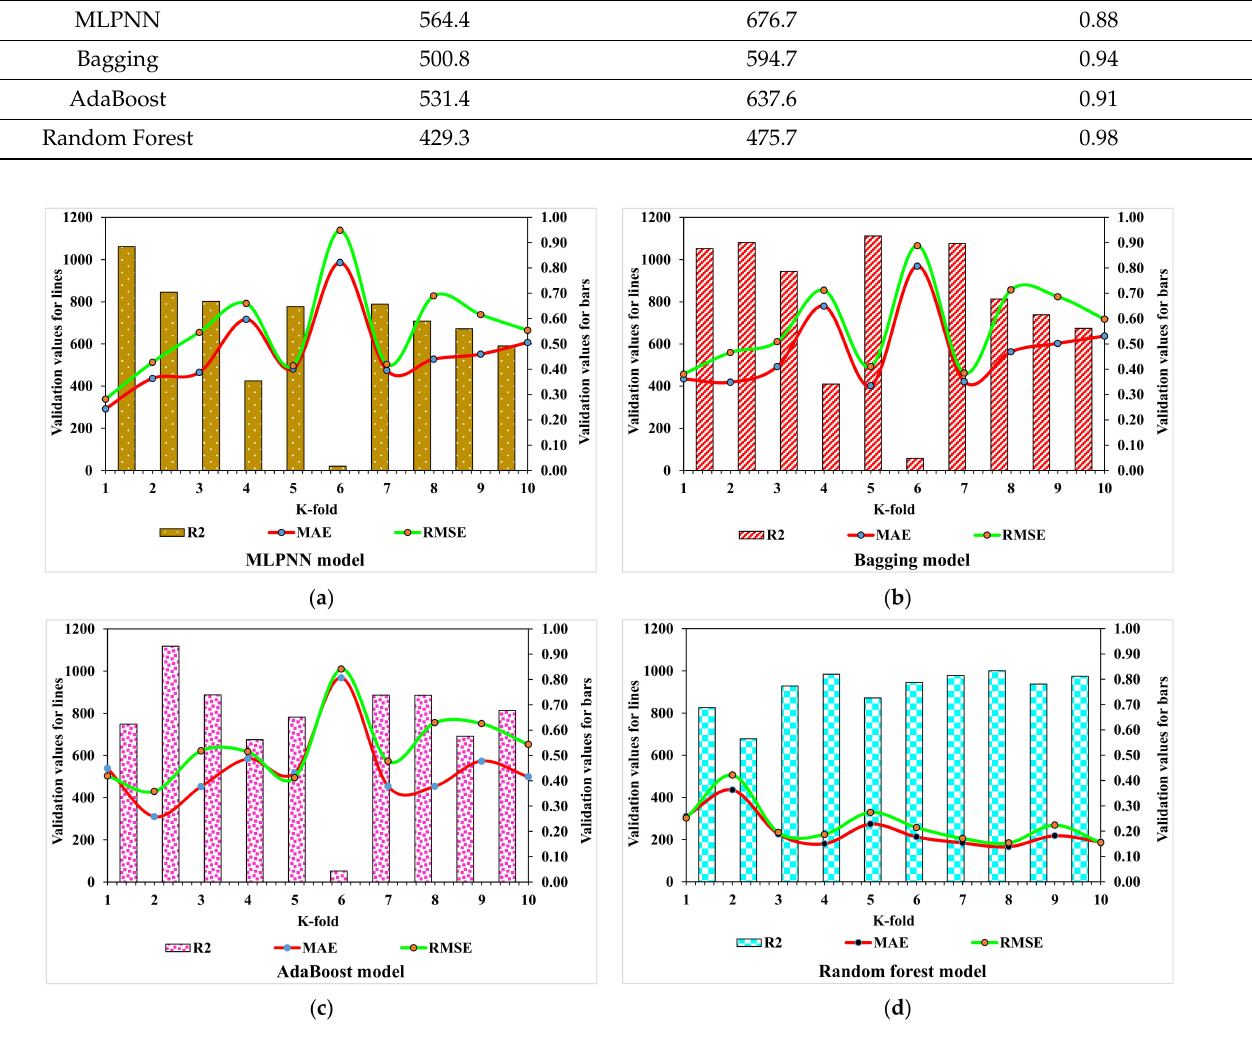
Figure 14. K-fold cross-validation: ( a ) MLPNN model; ( b ) Bagging model; ( c ) AdaBoost model; and ( d ) Random Forest